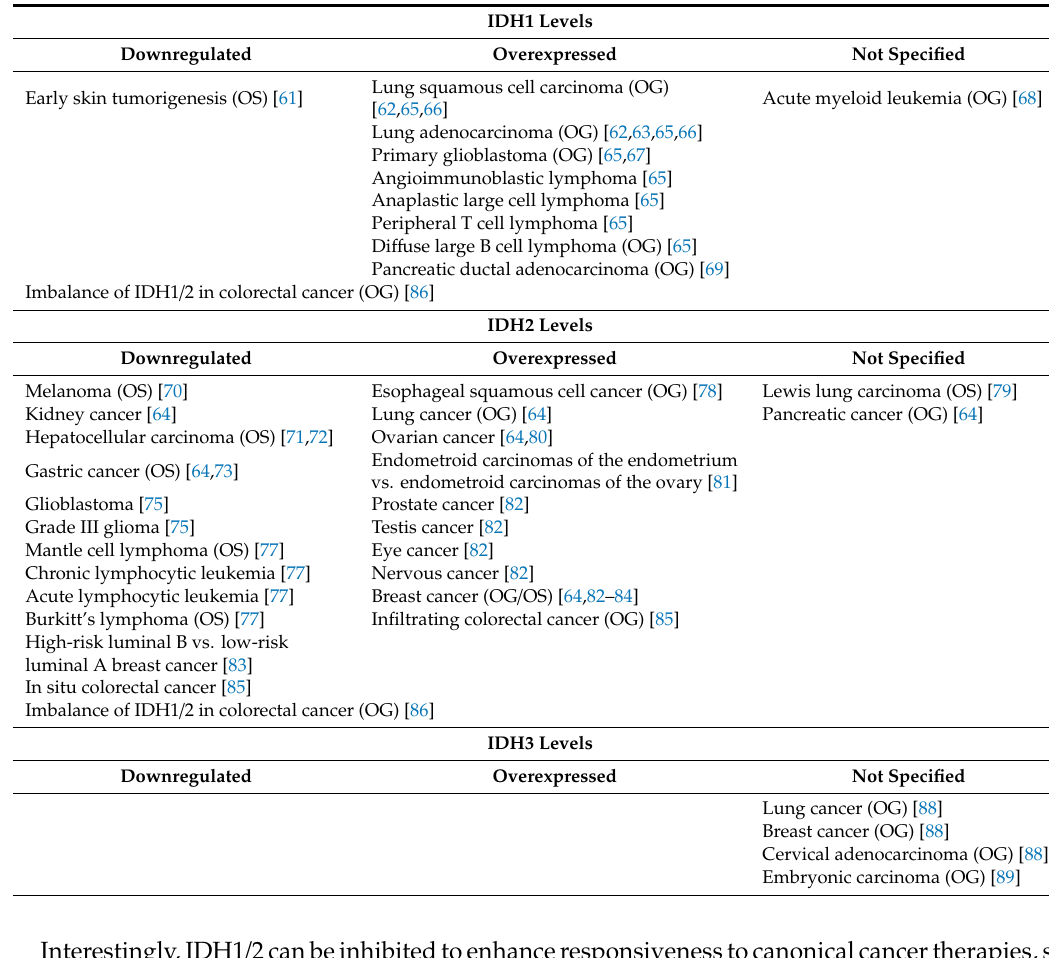
Table 2. IDH expression deregulation in cancers. IDH expression levels in the indicated cancers compared to healthy / benign disease tissues, if not otherwise specified. OS = putative oncosuppressive role; OG = putative oncogenic